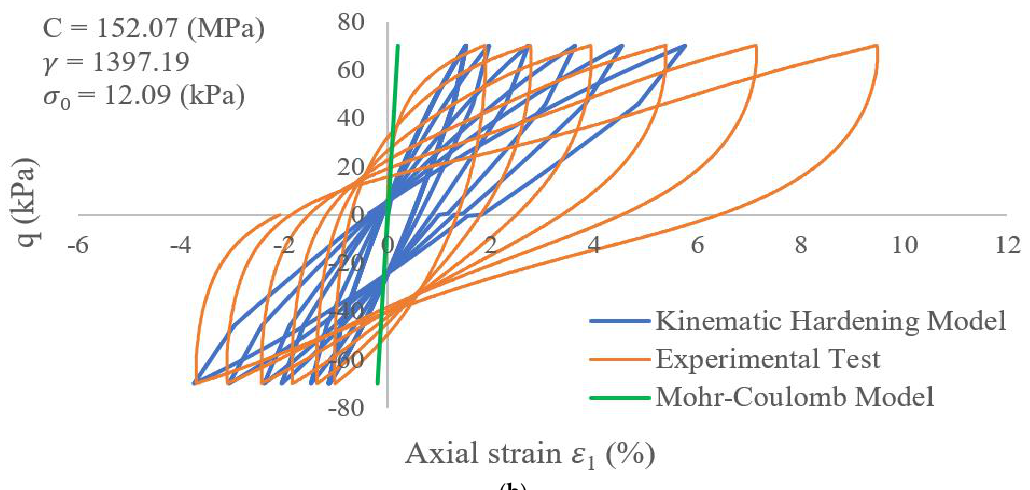
Figure 7. Comparison of the kinematic hardening model and Mohr–Coulomb model with experimental test data: ( a ) q = 60 kPa, ( b ) q = 70 kPa.